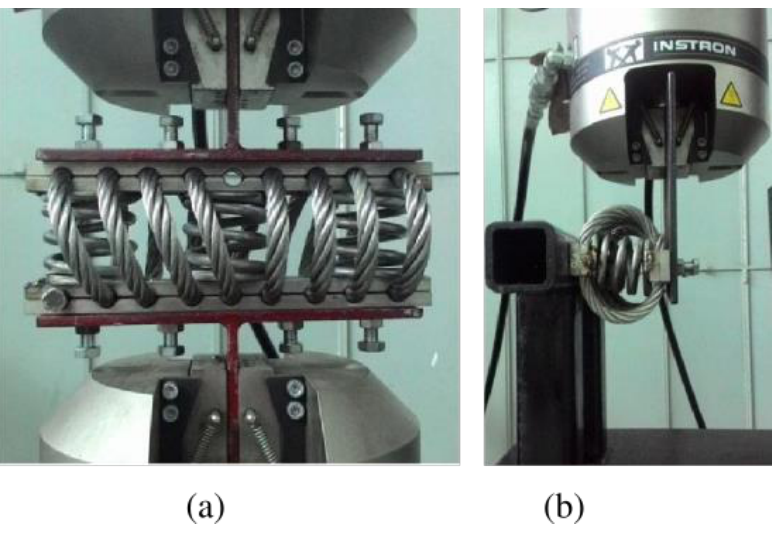
Figure 7. Test setup for S-WRI: ( a ) vertical and ( b ) lateral (roll). Table 4. Performance of S-WRI against WRI in terms of stiffness.